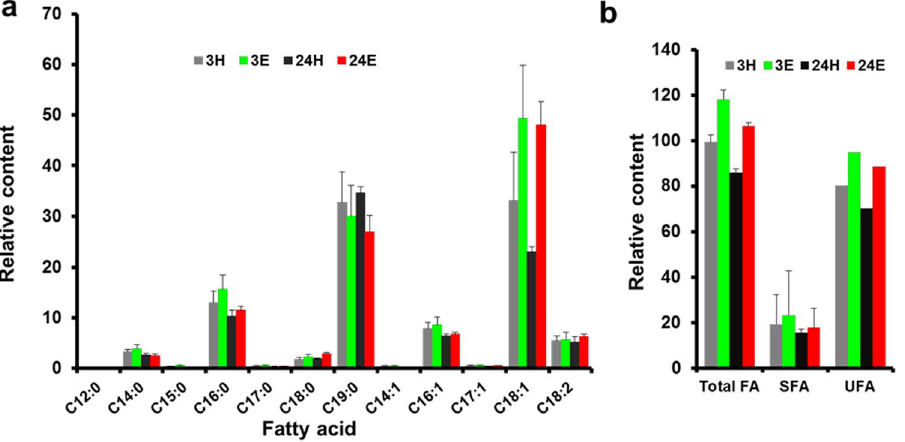
Figure 6. Composition and contents of fatty acids in L. acetotolerans F28 grown under stress of 12% (v/v) ethanol. ( a ) Fatty acids composition of L. acetotolerans F28 grown under stress of 12% ethanol. ( b ) Fatty acid contents of L. acetotolerans F28 grown under stress of 12% ethanol. SFA: saturated fatty acid, UFA: unsaturated fatty acid. 3 H: samples of 3 hours after 12% water treatment (control), 24 H:samples of 24 hours after 12% water treatment(control), 3E:samples of 3 hours after 12% ethanol treatment, 24E:samples of 24 hours after 12% ethanol treatment. Each sample was tested in